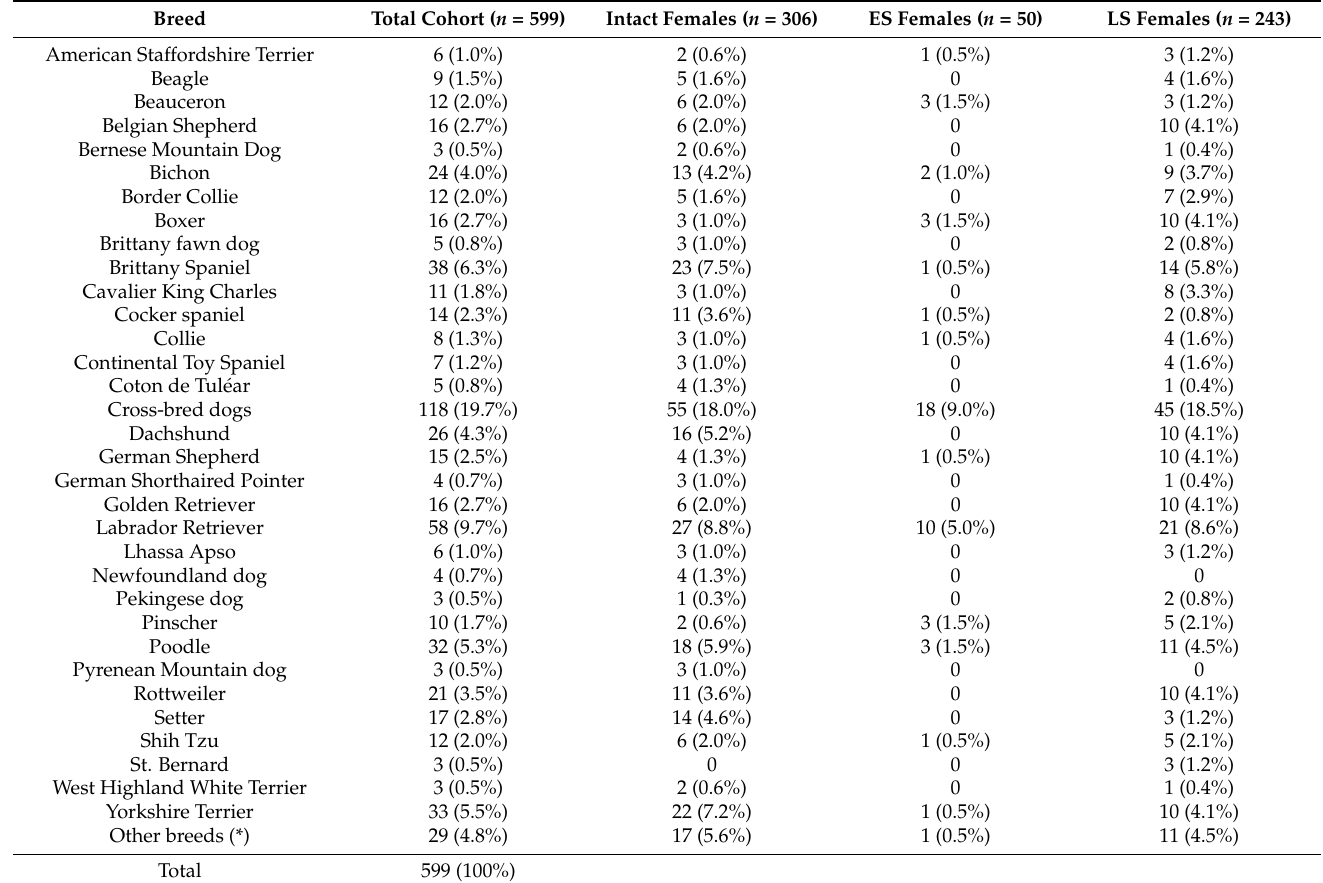
Table 1. Breed distribution of the studied cohort.